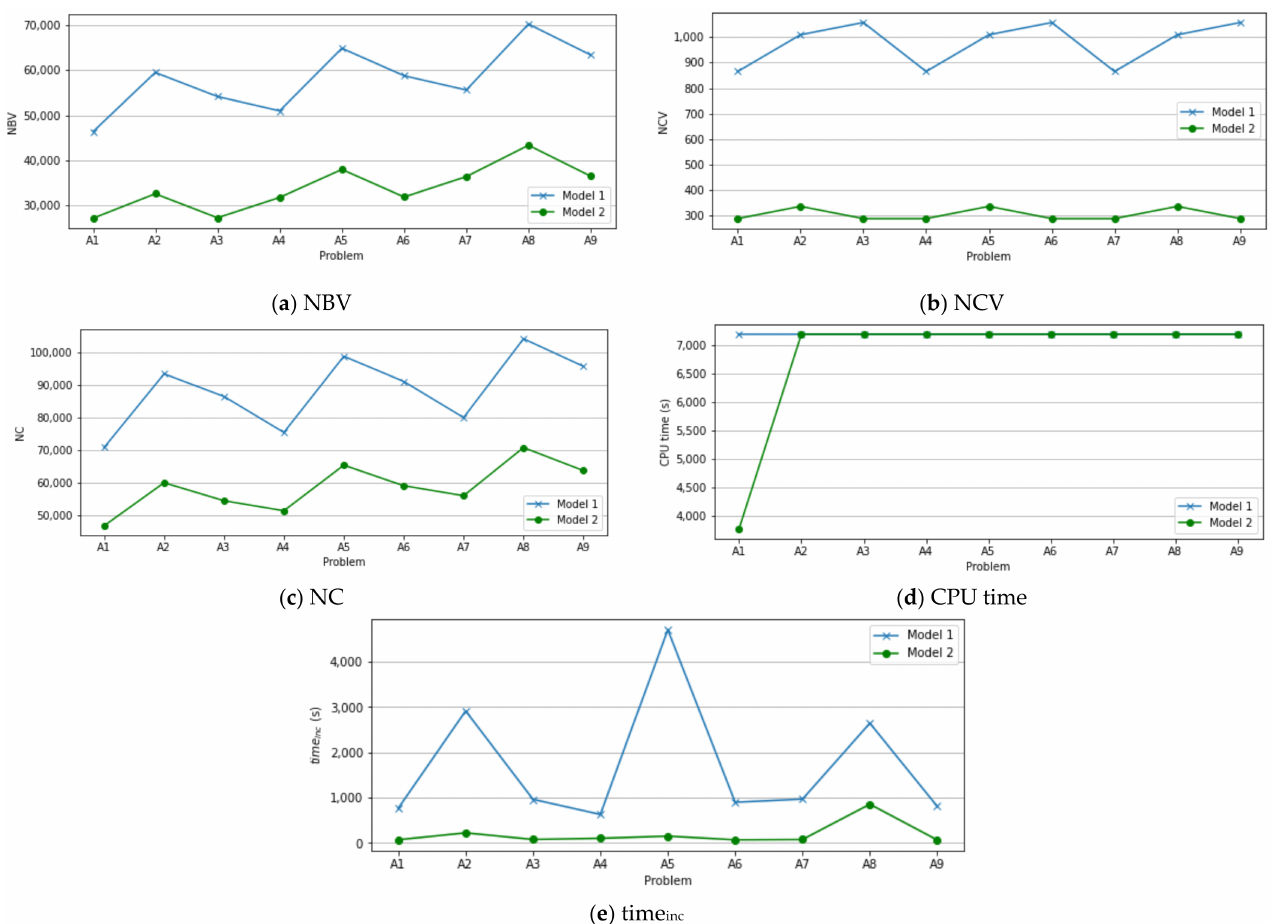
Figure 6. Comparison of the model size, as the ( a ) NBV (number of binary variables), ( b ) NCV (number of continuous variables), and ( c ) NC (number of constraints) and the ( d ) CPU time and ( e ) time inc (computational time to reach the incumbent solution) for solving the additional test problems between Model 1 and Model